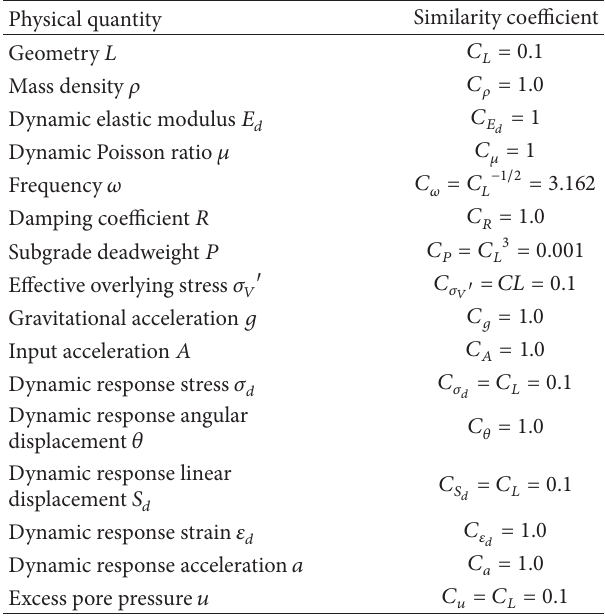
Table 3: Similitude coefficients of the shaking table model test.